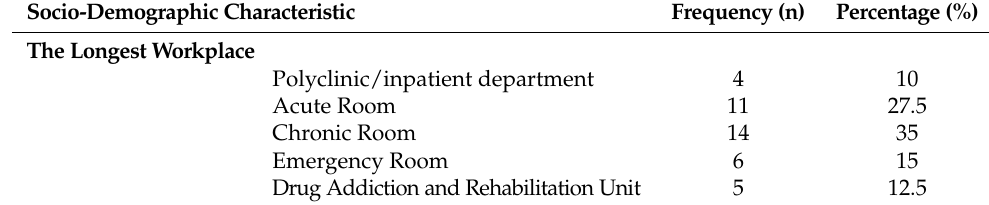
Table 1. Cont. Socio-Demographic